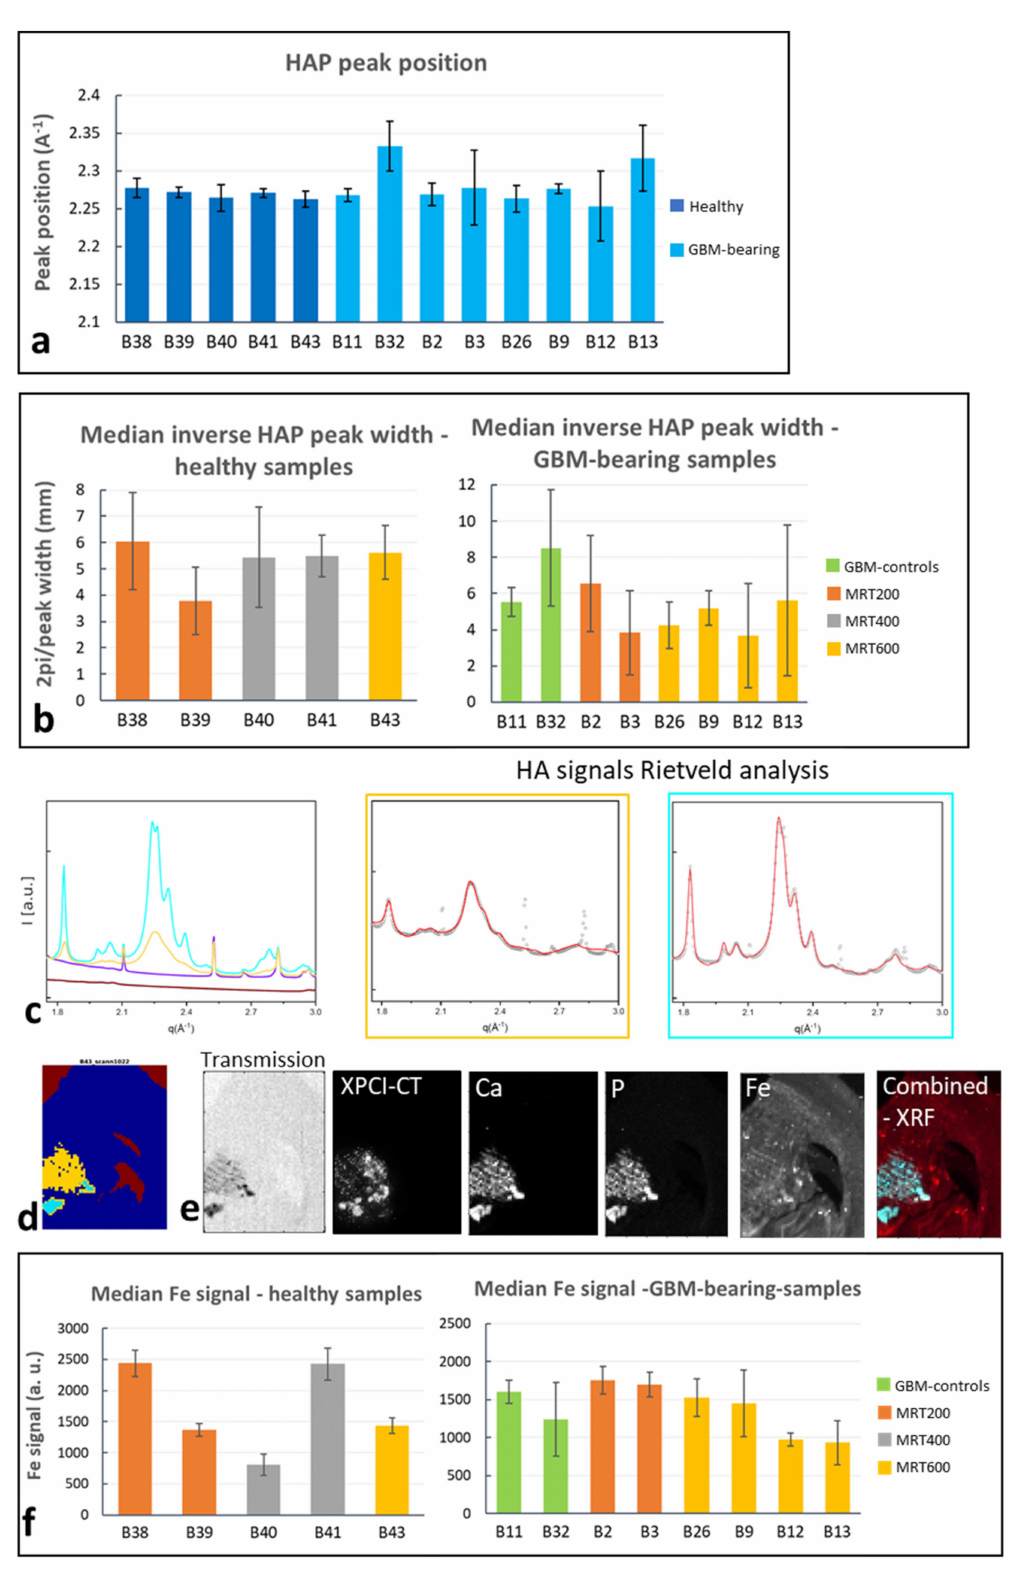
Figure 9. SAXS/WAXS and XRF data analysis for controls and MRT-treated samples. ( a ) Peak position graph of the samples showing hydroxyapatite (HAP) as crystallized phase for the Ca content. ( b ) Inverse peak width for healthy and GBM-bearing MRT-treated brains. The reported value is the median over all the detected signals within the q-range from 2.20 Å − 1 to 2.34 Å − 1